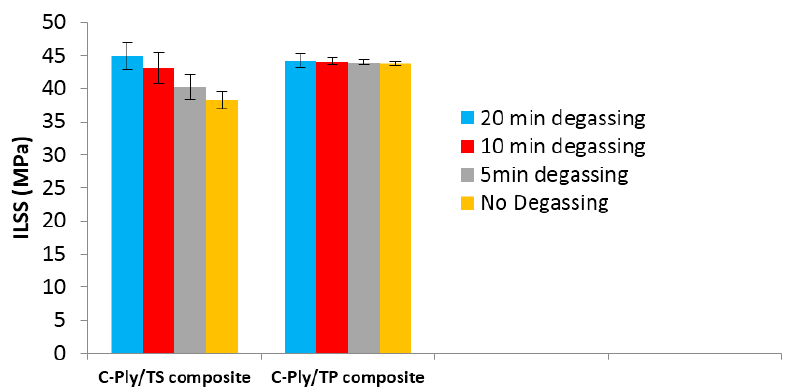
Figure 4. Effect of resin degassing on Interlaminar Shear Strength (ILSS) test properties of C-Ply TM composites.